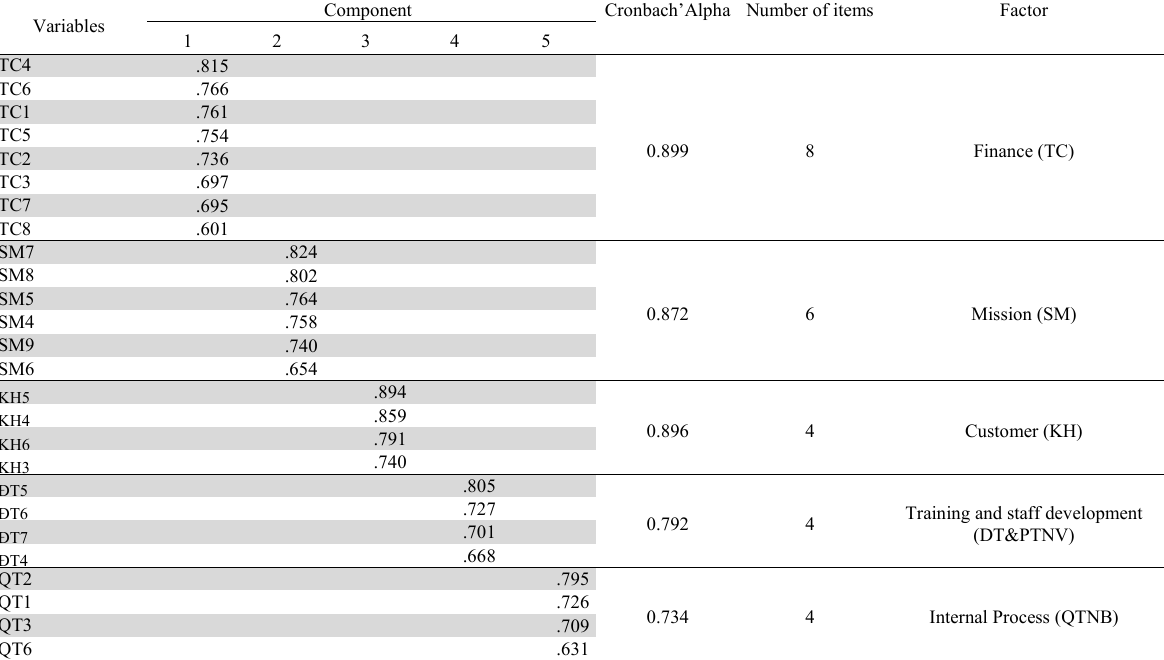
Cronbach Alpha coefficients and load factors of variables in each factor Variables